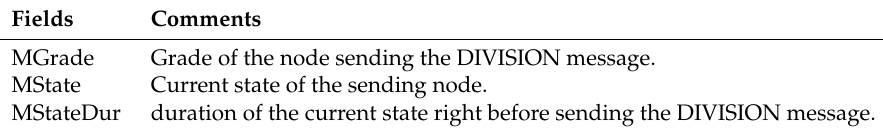
Table 2. Frame Format of DIVISION message.